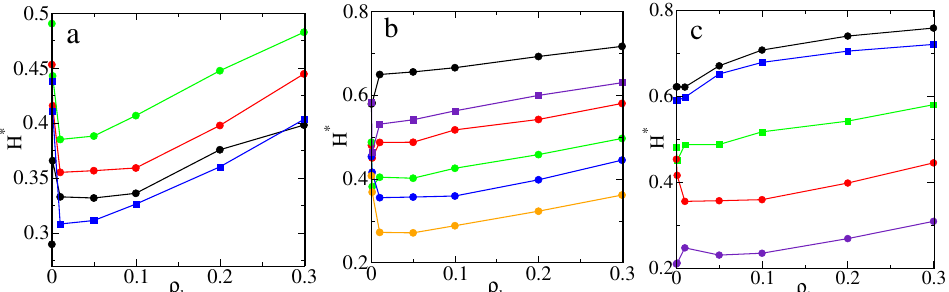
Figure 2. The average thicknesses of the corona for the model M1 and ε Ps = 1.5 ε : ( a ) the hairy particle, σ c = 4 σ , M = 20 (circles): f = 10 (black), 20 (red), 30 (green), and M = 30, f = 30 (blue squares), ( b ) the hairy particle, σ c = 4 σ , f = 20 (circles): M = 5 (black), 10 (red), 15 (green), 20 (blue), 30 (yellow), and f = 30, M = 10 (violet squares), ( c ) M = 20 and ρ gr = 0.398 (circles): the flat substrate, f = 20 (black), the hairy particle, σ c = 4 σ , f = 20 (red), the hairy particle, σ c = 2 σ , f = 5 (violet), and f = 20, M = 10 (squares): the flat substrate (blue), the hairy particle, σ c = 4 σ (green). Symbols correspond to simulation points. Lines serve as a guide to the